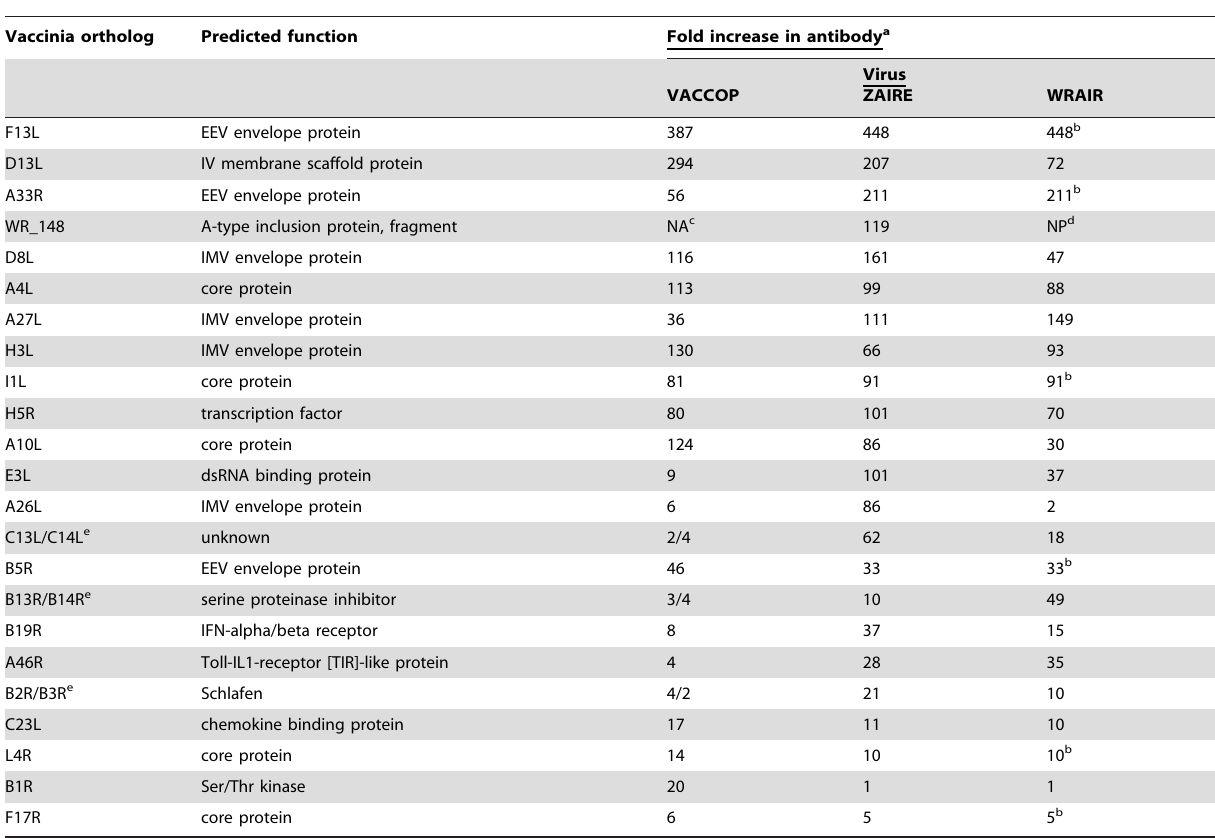
Table 3. Orthopoxvirus proteome recognized by IgG in convalescent